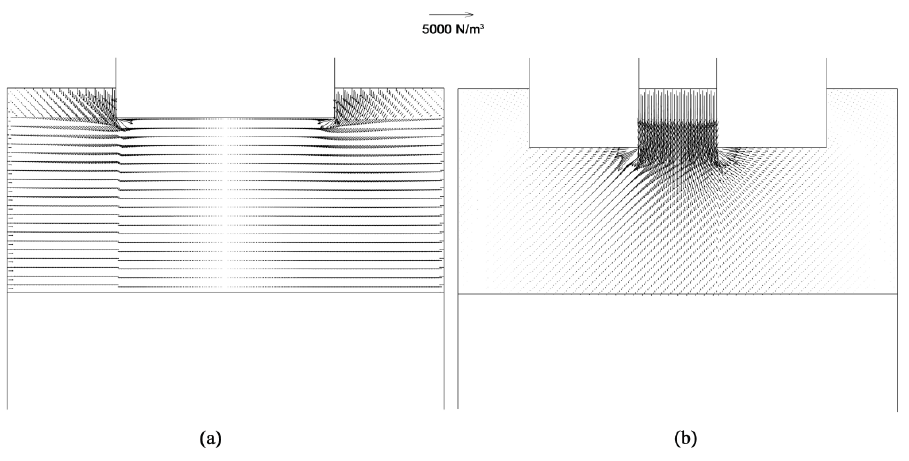
Figure 8. Vector diagram of electromagnetic force. ( a ) OE-ESR. ( b ) TSCE-ESR.